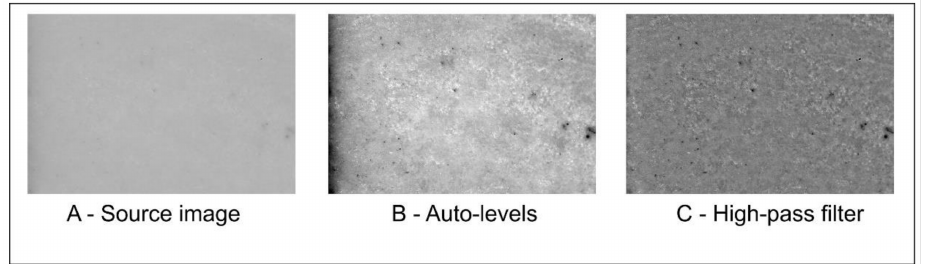
Figure 3. Graphical operations. ( A ) Source image, ( B ) image after auto-levels, ( C ) high-pass filter